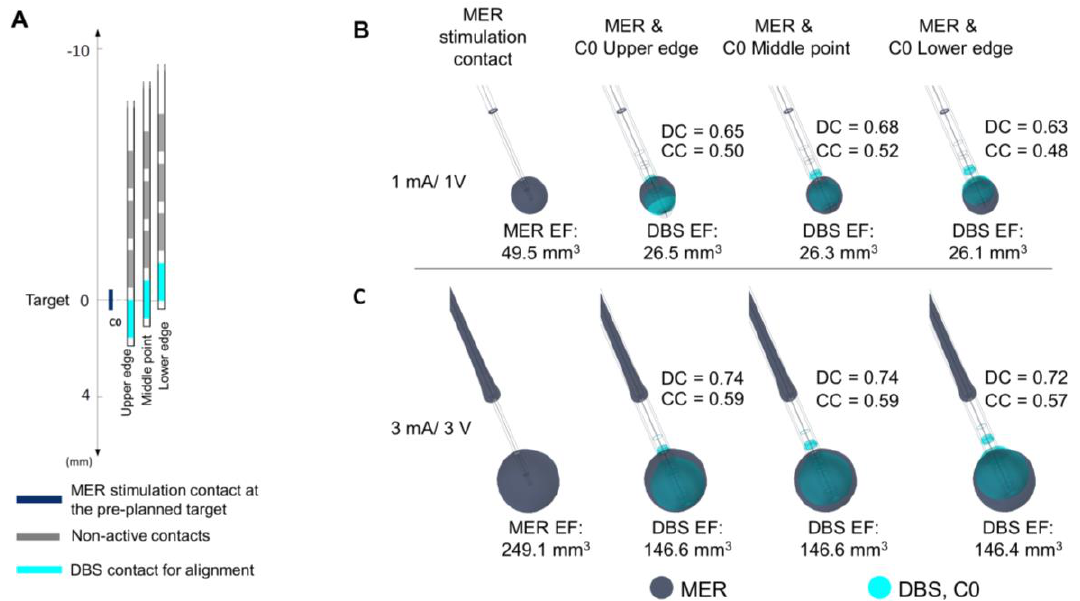
Figure 6. Evaluation of the position of the DBS contact in heterogeneous tissue (σ ≈ 0.079 S/m). ( A ) Displacement of the DBS lead to match the lower edge, the middle point, and the upper edge to the middle point of the MER stimulation contact localized at the target. Overlay of the EF isosurfaces (0.2 V/mm) simulated for the MER stimulation contact (dark blue) and the DBS first contact C0 (cyan) set to ( B ) 1 mA and 1 V and ( C ) 3 mA and 3 V, respectively. EF volume within the selected isosurface shown below the lead. DC and CC shown to the right of each lead.